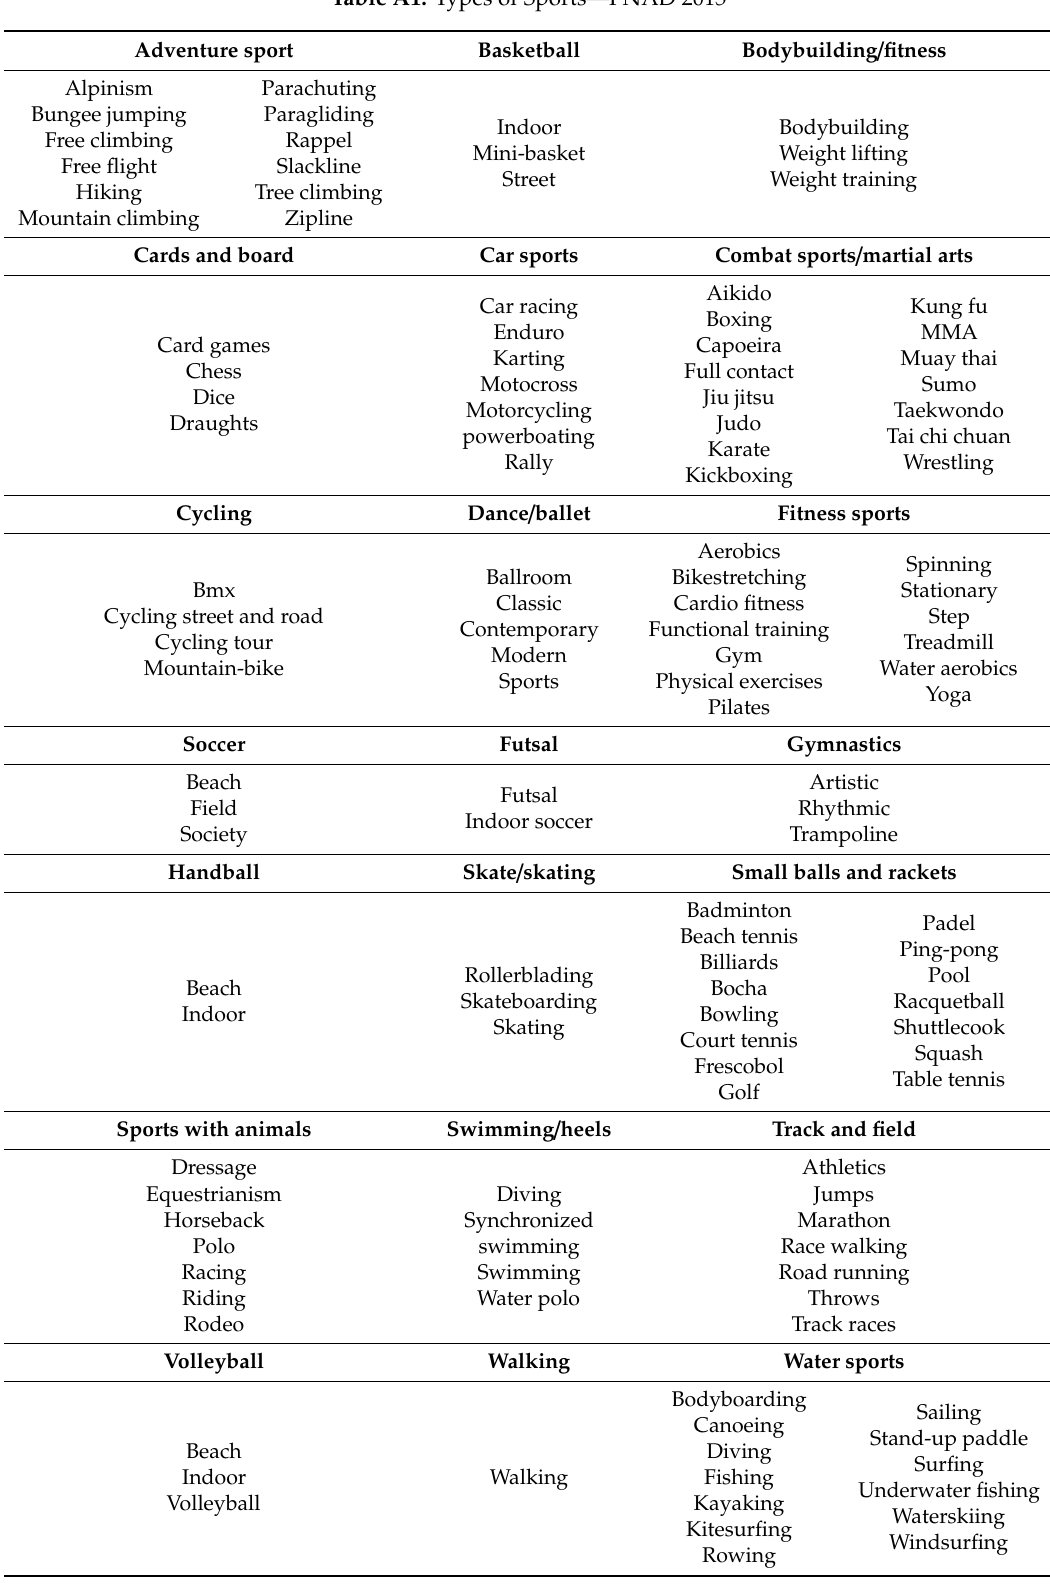
Table A1. Types of Sports—PNAD